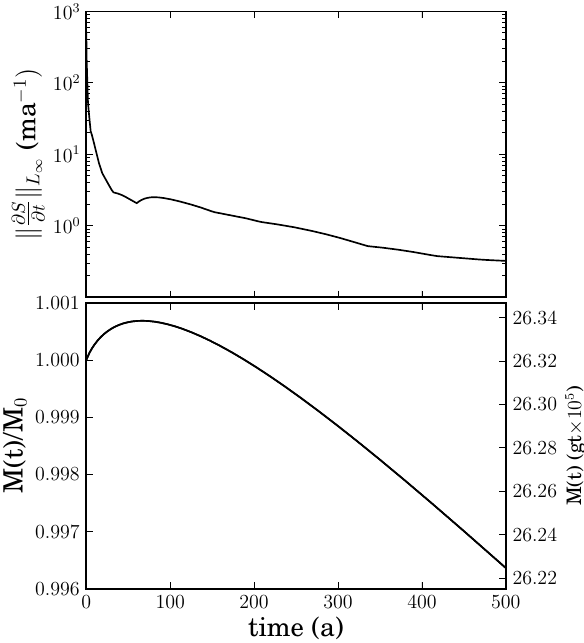
Fig. 14. The L ∞ norm of the surface elevation change field and the total ice mass over a 500-year model run.